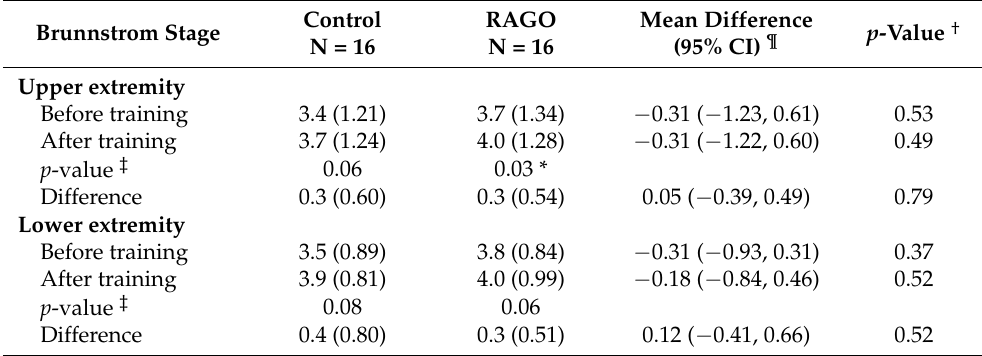
Table 4. Brunnstrom Stage Before and After Training.